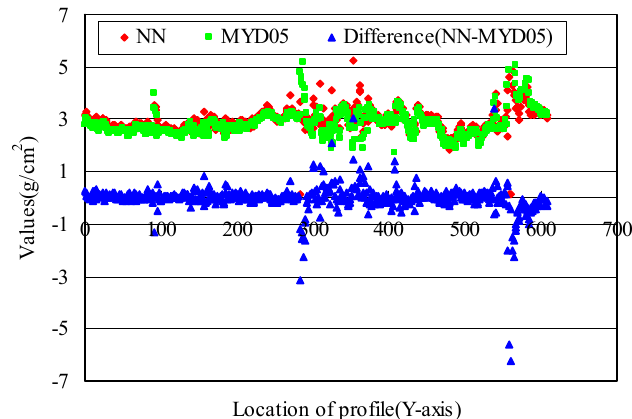
Figure 7. The Y -axis profile in Figures 3–5.